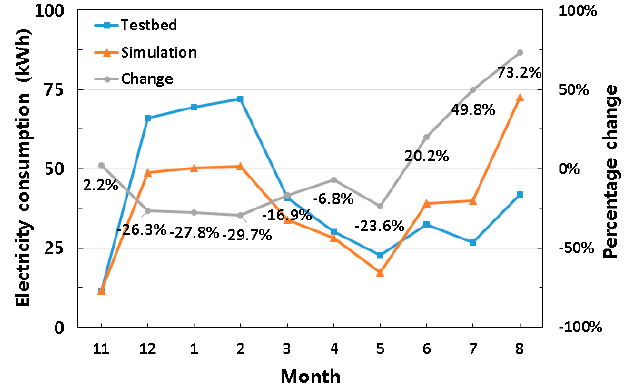
Figure 9. Case 2: Anseong weather data + single-speed operation heat pump.